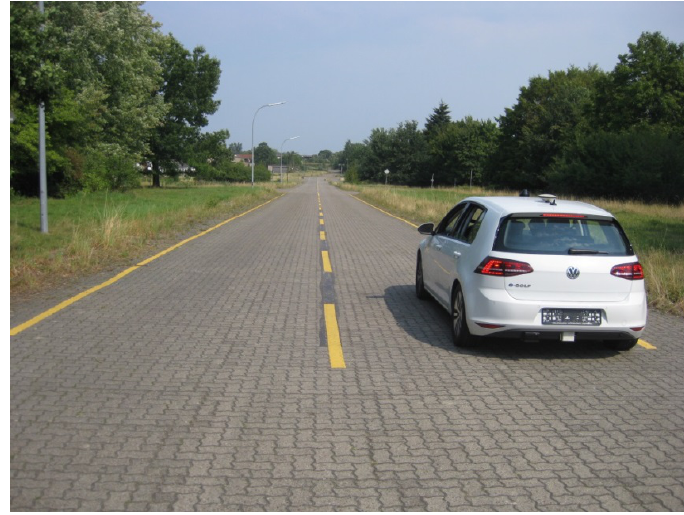
Figure 1: FASCar ®